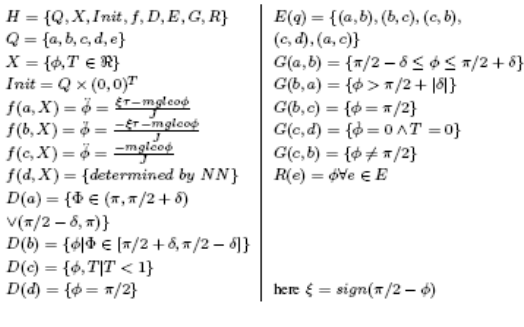
TABLE 2: WIP AS HYBRID